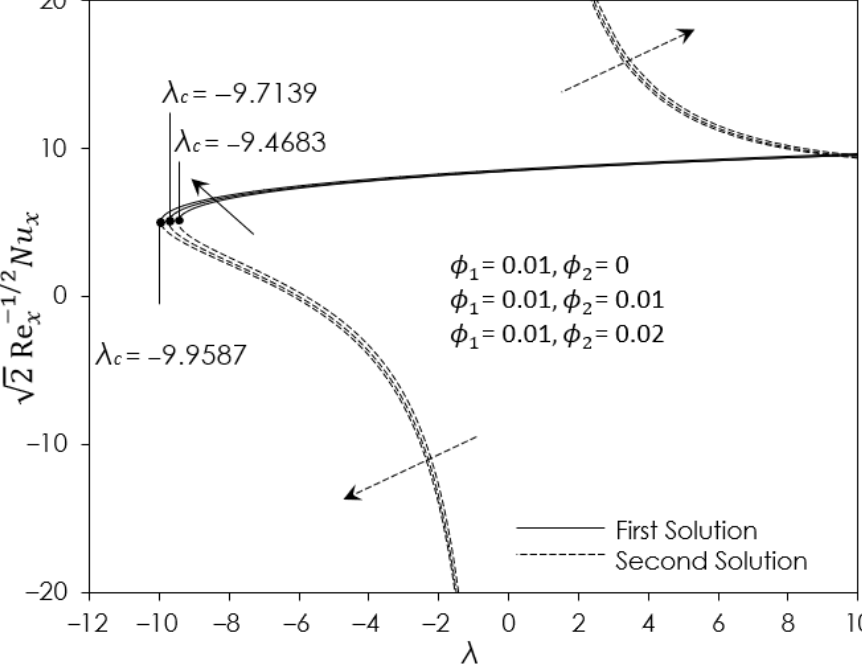
√ Figure 3. Variation of 2 Re − 1/2 x Nu x for different values of φ 2 . Figure 3. Variation of √2 Re 𝑥−1/2 𝑁𝑢 𝑥 for different values of 𝜙 2 . Figure 4 delineates the magnetic parameter 𝑀 impact on √2 Re 𝑥1/2 𝐶 𝑓 with 𝜆 . The in-